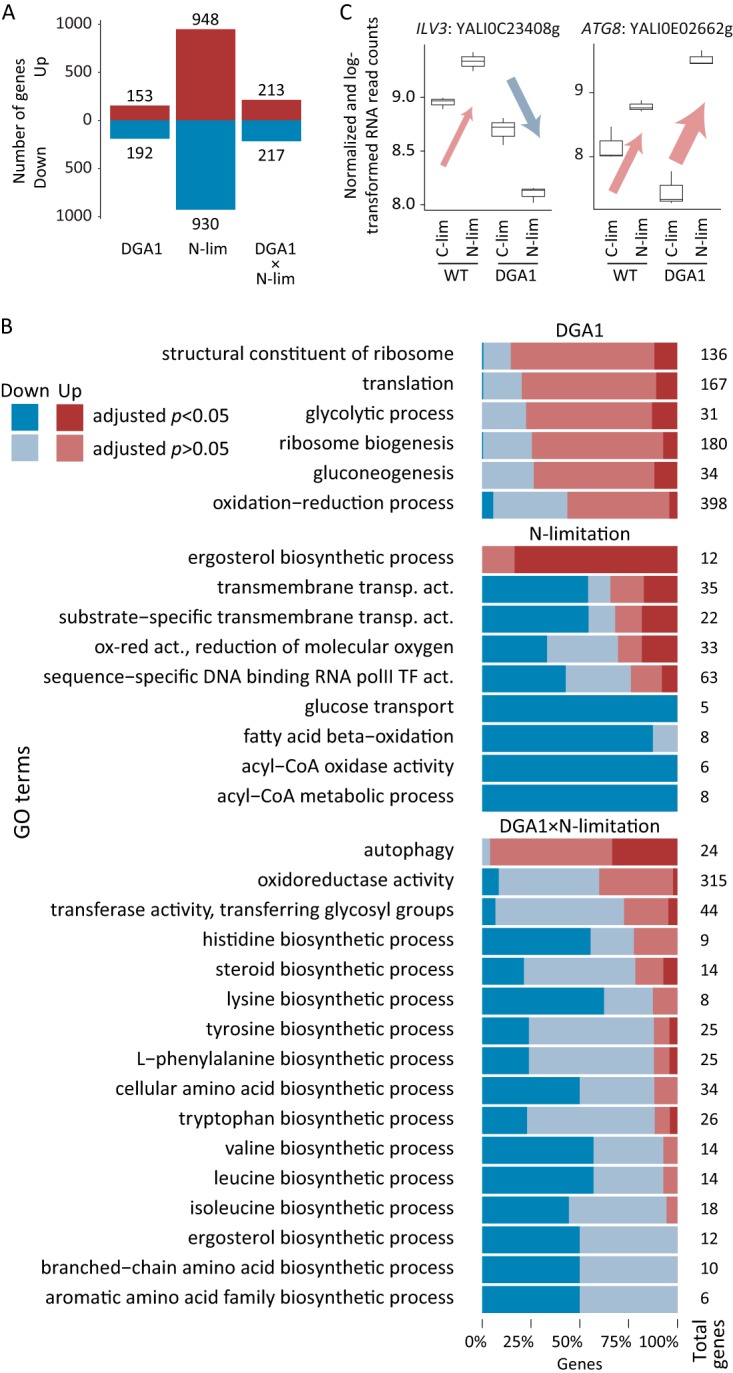
Consensus gene-set analysis using differential RNA expression according to a general linear model. (A) Overview of number of genes whose expression values were significantly (adjusted P < 0.05) influenced by DGA1 overexpression (DGA1), nitrogen limitation (N-lim), or the DGA1 × N-lim interaction. (B) GO term enrichment analysis. For each significantly changed GO term (rank score of ≤5), the direction and significance of the changes in RNA levels of their constitutive genes are shown, together with the total number of genes within each GO term. ox-red, oxidation-reduction; polII, polymerase II; TF, transcription factor; transp. act., transporter activity. (C) Expression profiles of ILV3, involved in leucine biosynthesis, and ATG8, involved in autophagy, exemplifying the factorial effects. acyl-CoA, acyl-coenzyme A.